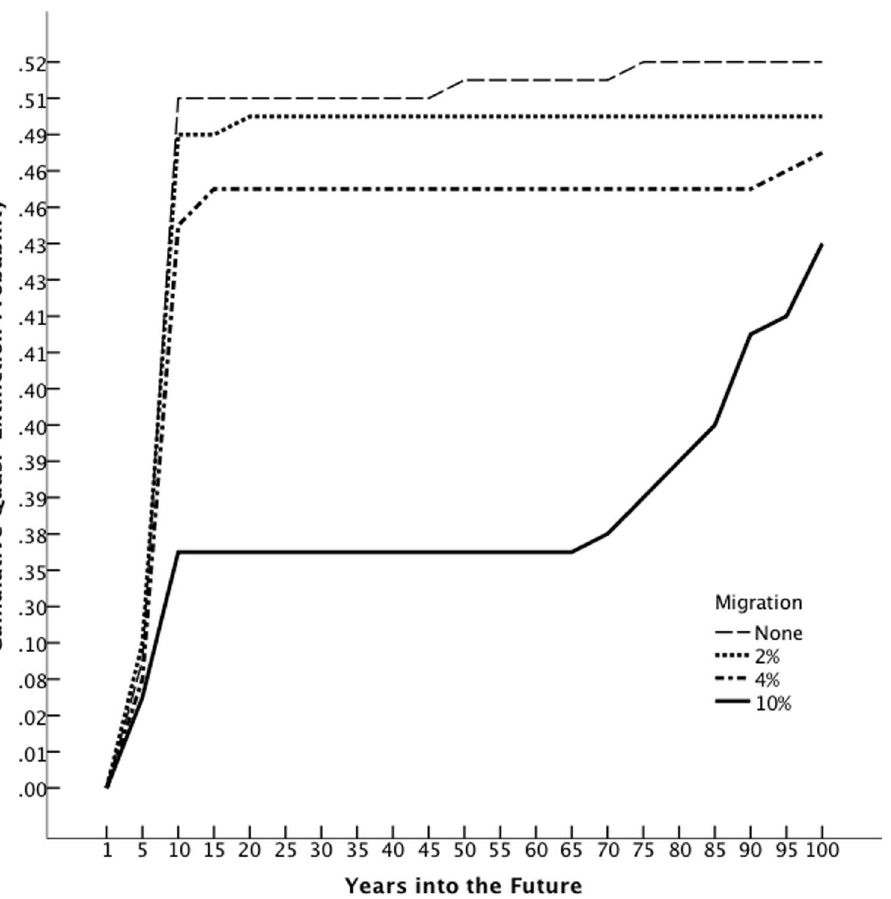
Figure 5. Cumulative quasi-extinction probability (set at ten individuals per stage class) for WR and LM populations combined with different migration